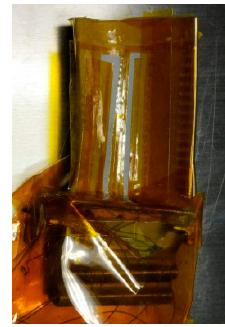
Figure 3. Surface graphic process.